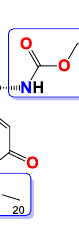
Figure 6. Structure of compound 6 .